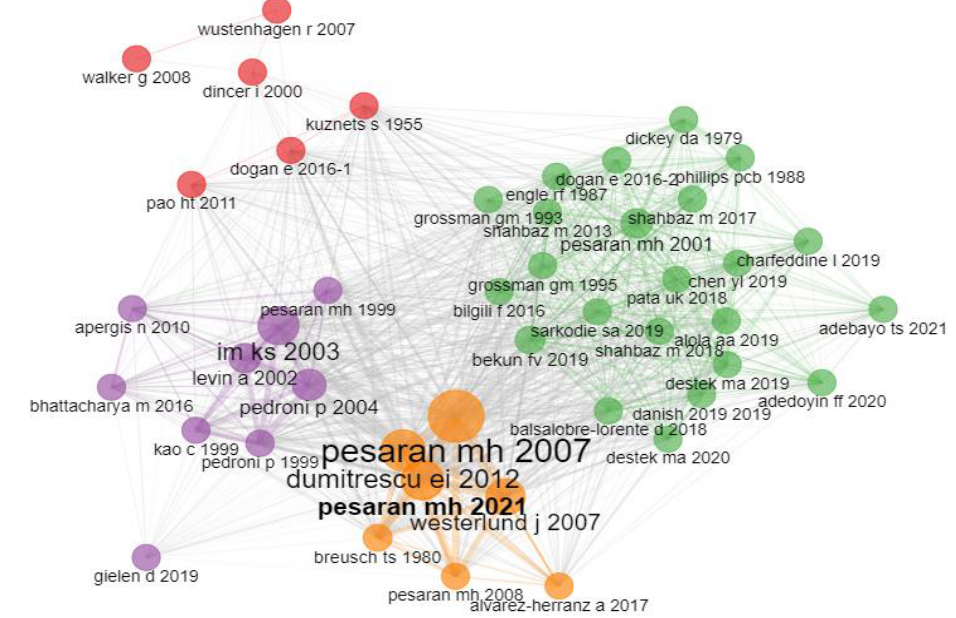
Figure 7. Co-citation network .